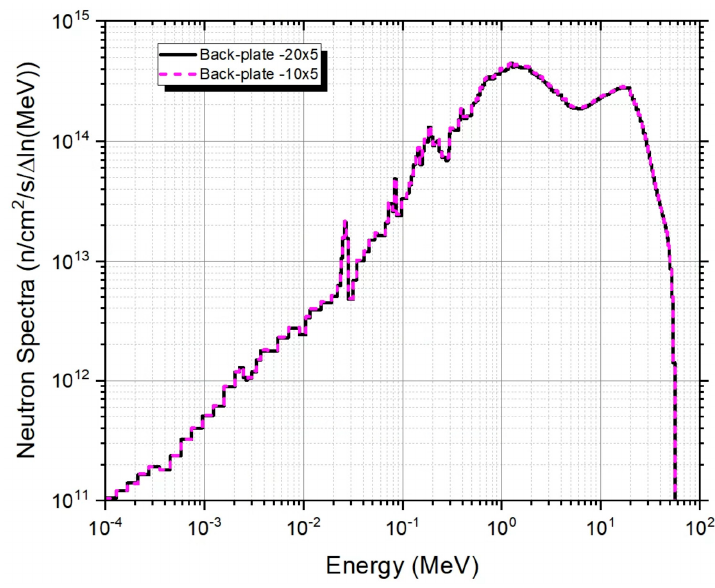
Figure 4. Neutron spectra on the BP with two beam footprints.